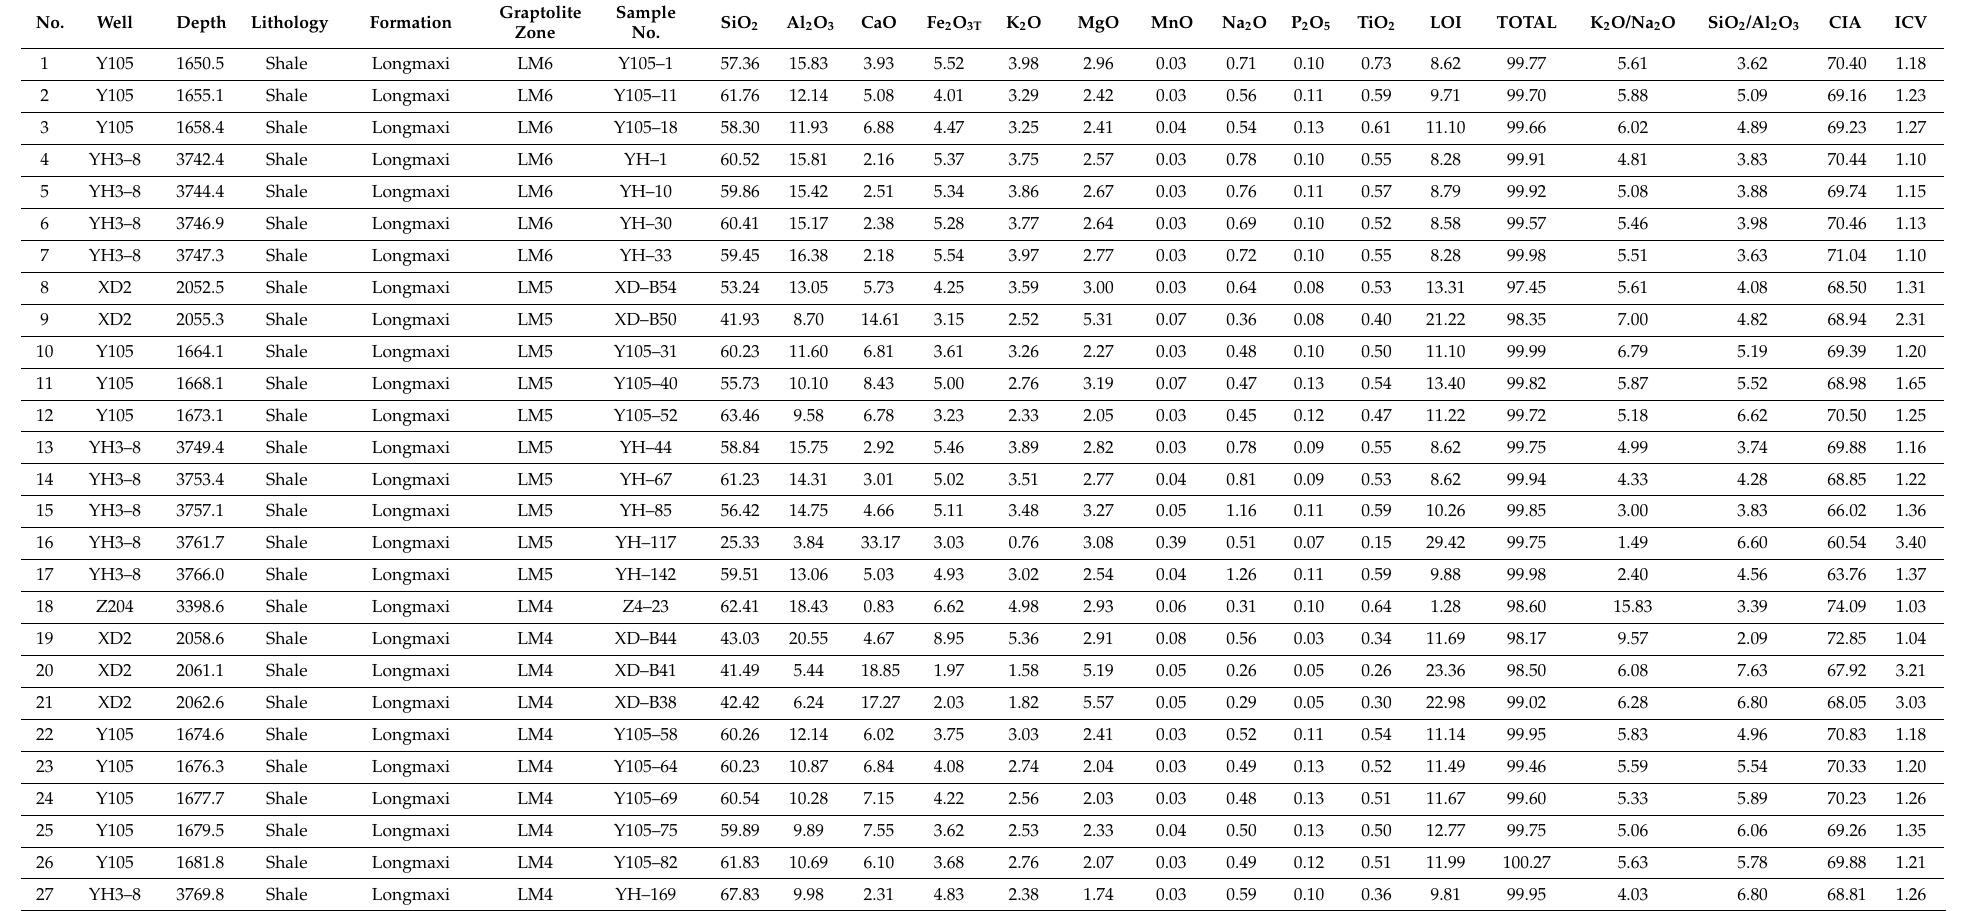
Table 2. Major element concentrations and organic carbon contents of the Wufeng–Longmaxi shale on the Yangtze Platform, South